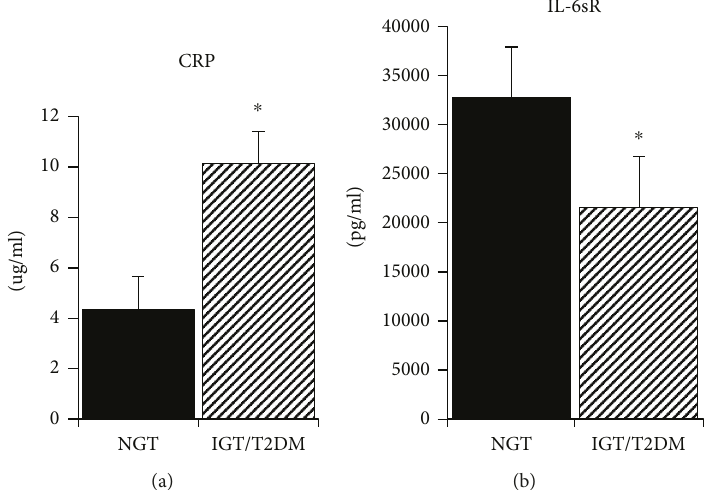
Figure 1: (a) CRP levels in NGT and IGT/T2DM groups. Values are mean ± SEM . Signi fi cantly di ff erent between groups, ∗ P < 0 01 . (b). IL-6sR levels in NGT and IGT/T2DM groups. Values are mean ± SEM . Signi fi cantly di ff erent between groups, ∗ P < 0 01 .